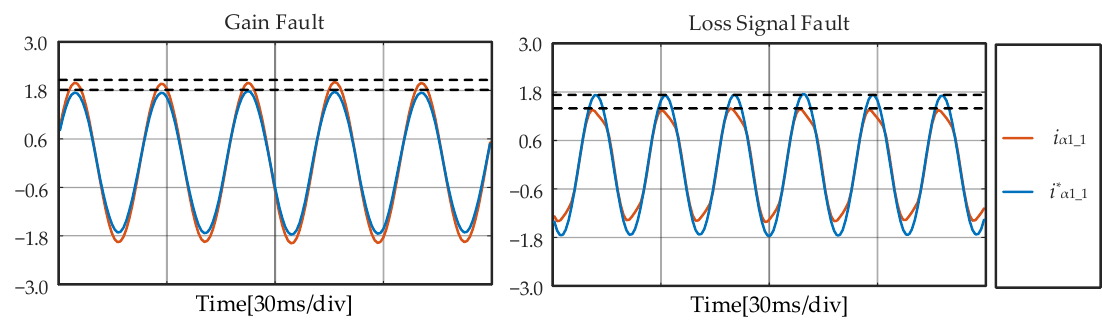
Figure 8. i α 1_1 and i * α 1_1 in different faults.